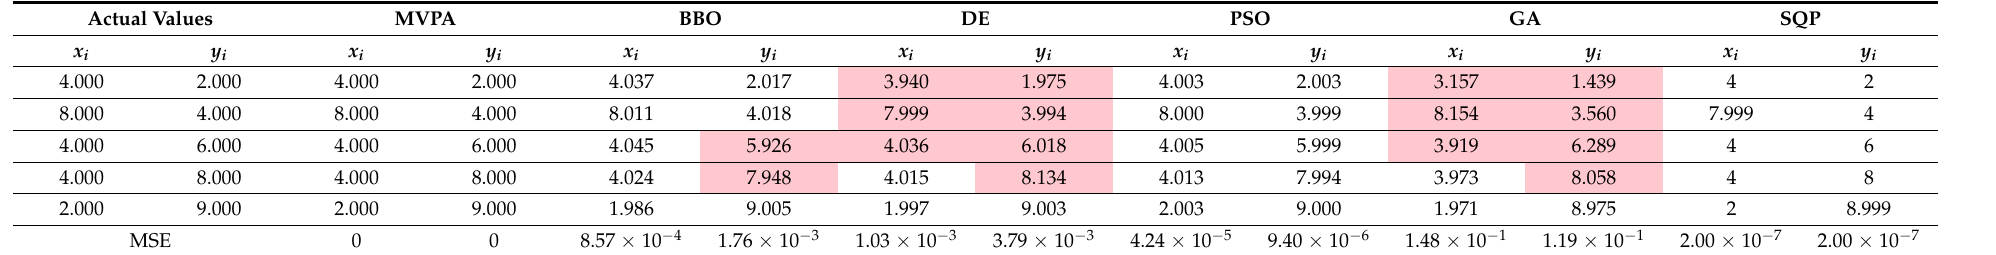
Table 1. Comparison of actual locations with those obtained using different algorithms for case 1.